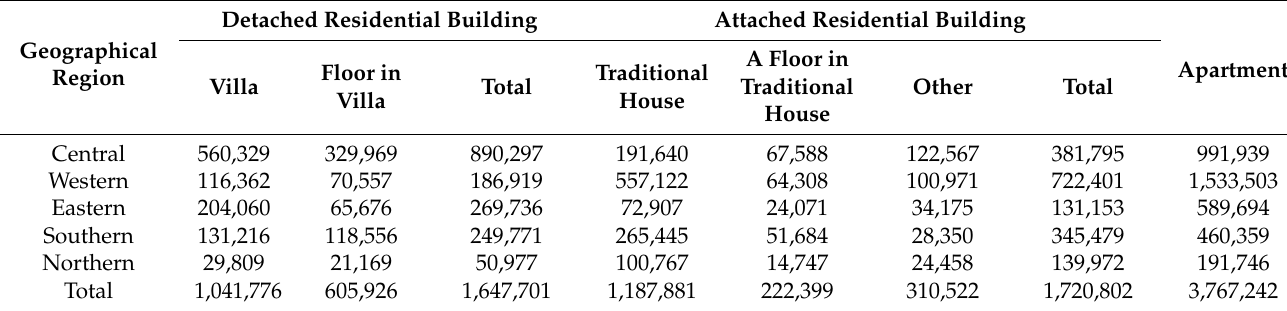
Table 1. Classified residential building distribution by geographical region in Saudi